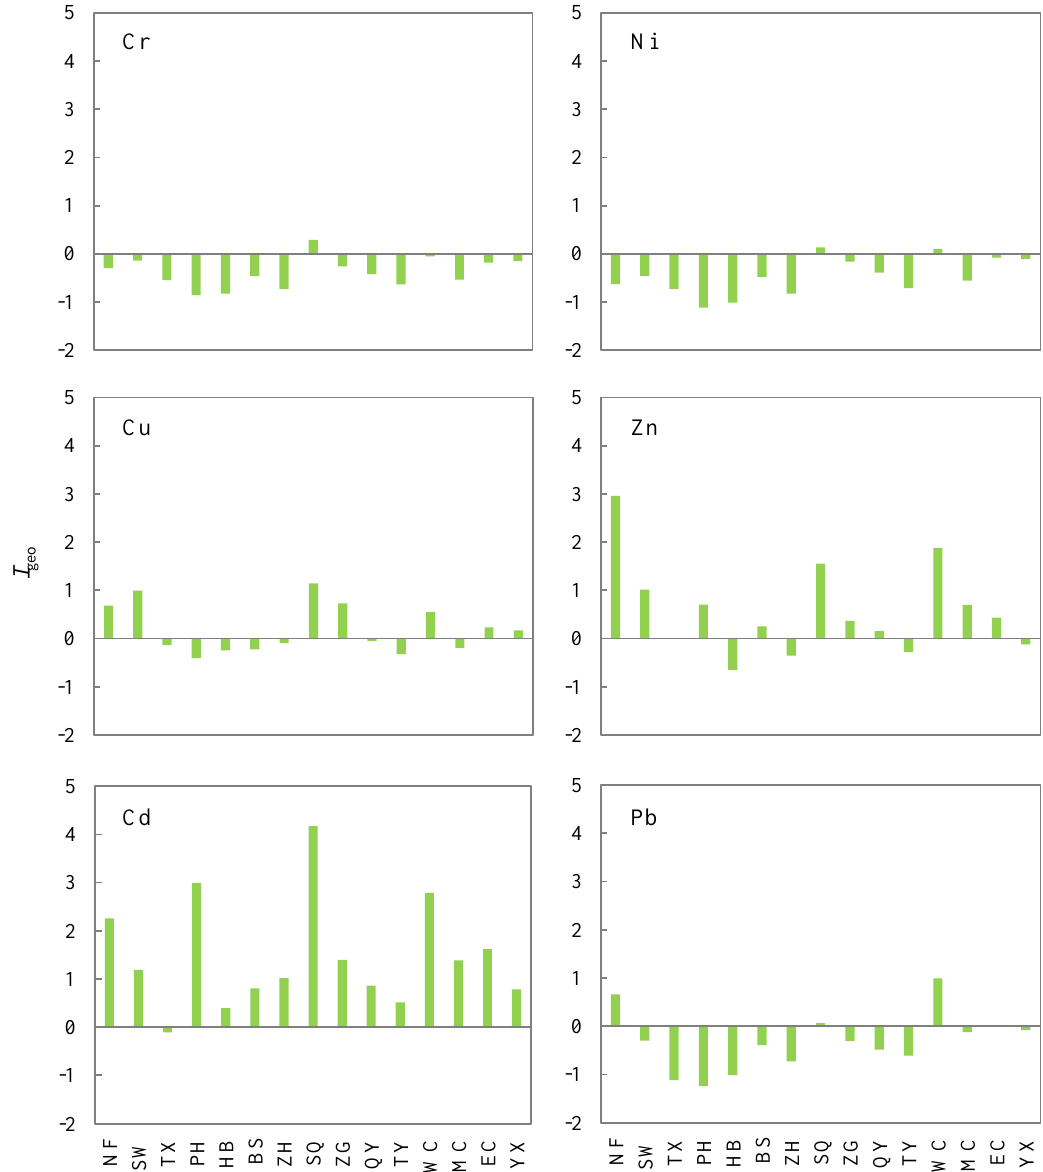
Figure 4. Geoaccumulation index ( I geo ) in sediments from 15 sampling